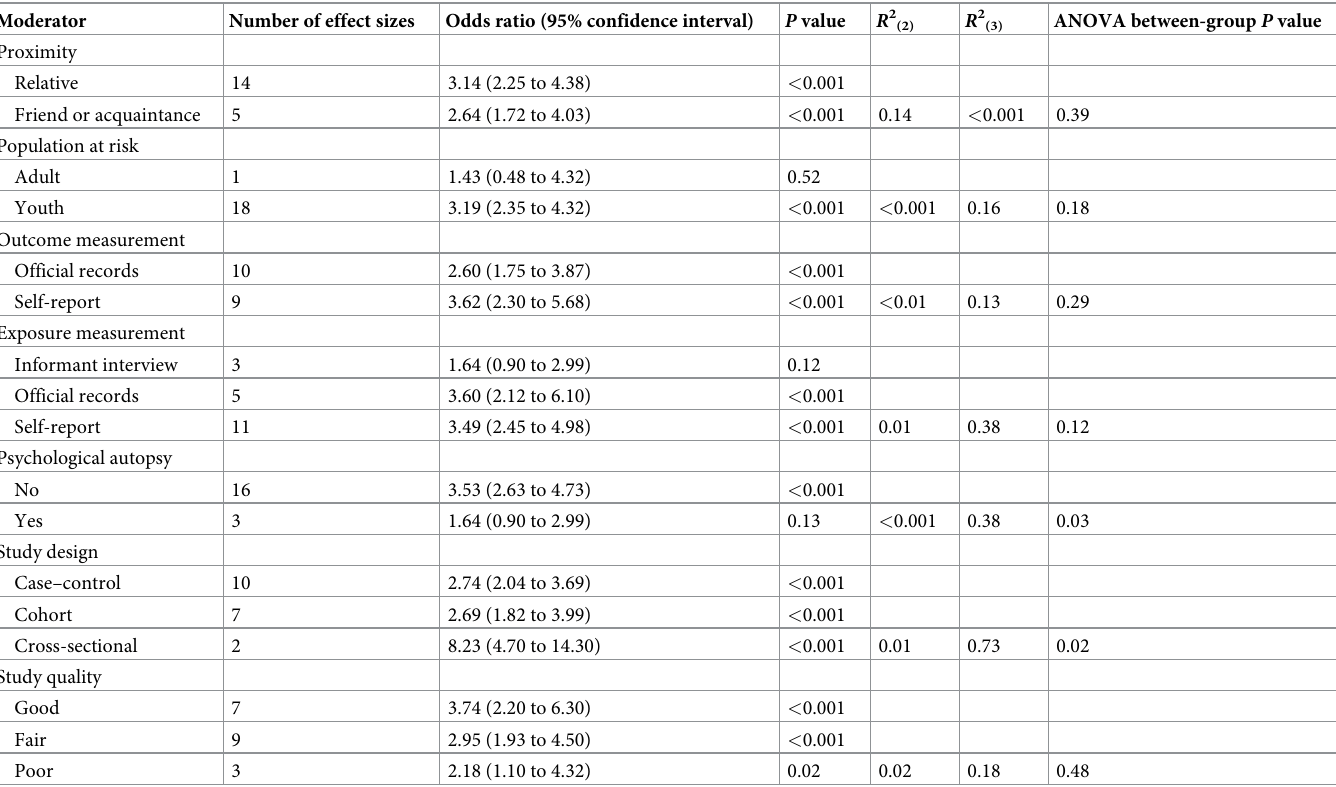
Table 3. Results of moderator analyses of exposure to suicide attempt across suicide, suicide attempt, and suicidal ideation